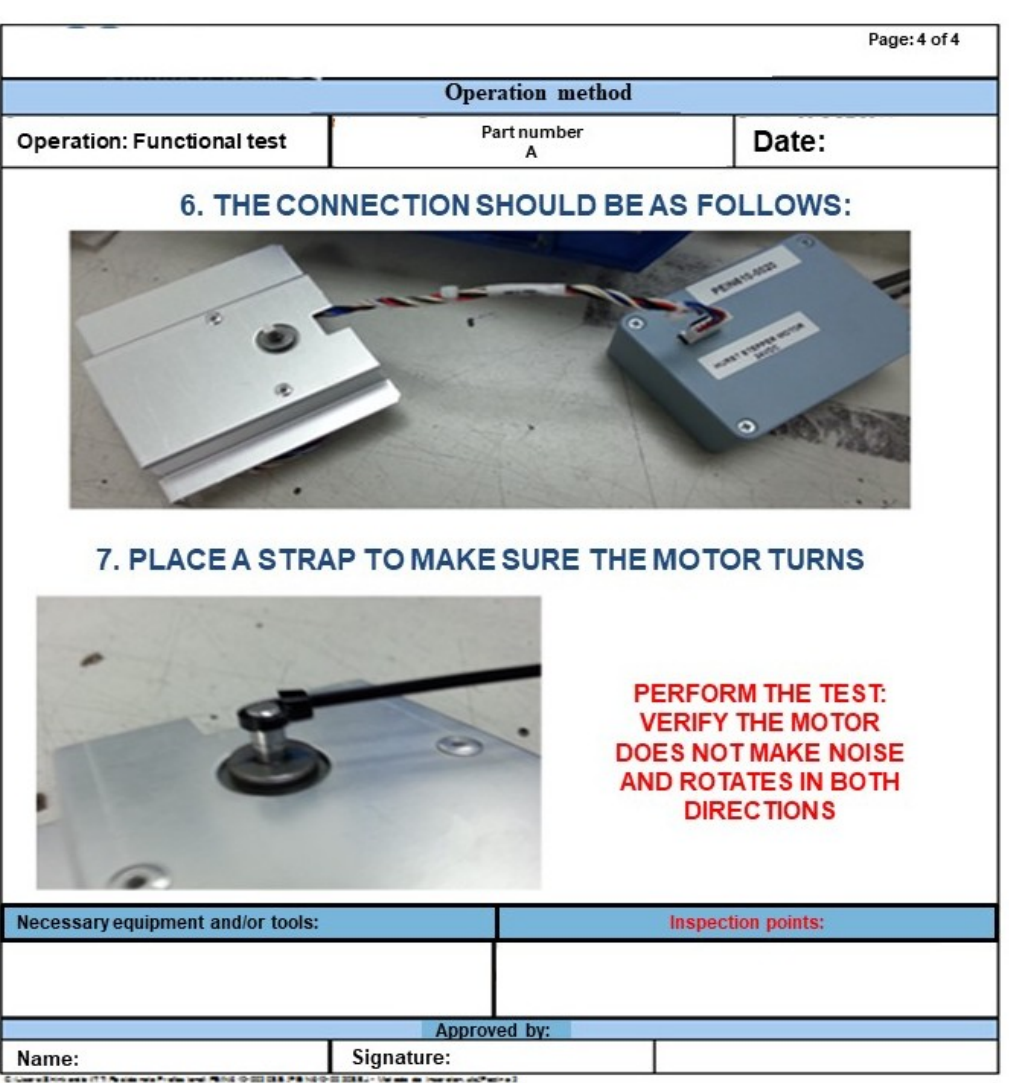
Figure 4. Fourth Visual Aid to Conducting the Functional Test. Figure A4. Fourth Visual Aid to Conducting the Functional